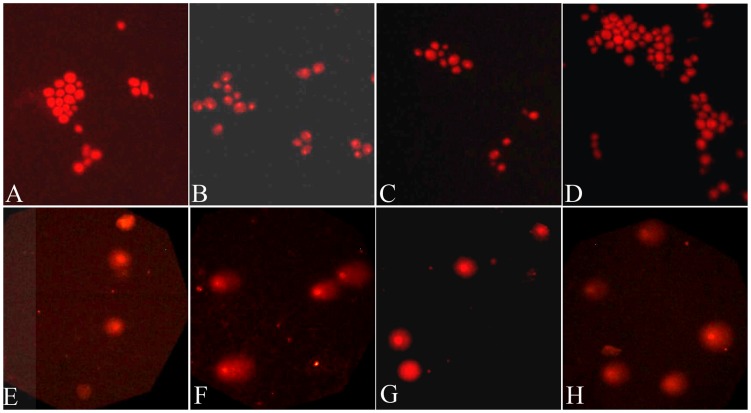
Chromium compounds induce DNA damage in yeast (A–D) and Jurkat cells (E–H).(A, E) Cells were not treated with chromium or a DNA damage treatment. (B) Cells were treated with 20 µM H2O2 for 30 minutes. (C, G) Cells were treated with 300 µM CrO3 for 24 hours. (D, H) Cells were treated with 150 µM CrCl3 for 24 hours. (F) Cells were exposed to UV for 1 hour. The slides were viewed using a fluorescent microscope at magnification 200× (A–D) and 100× (E–H).